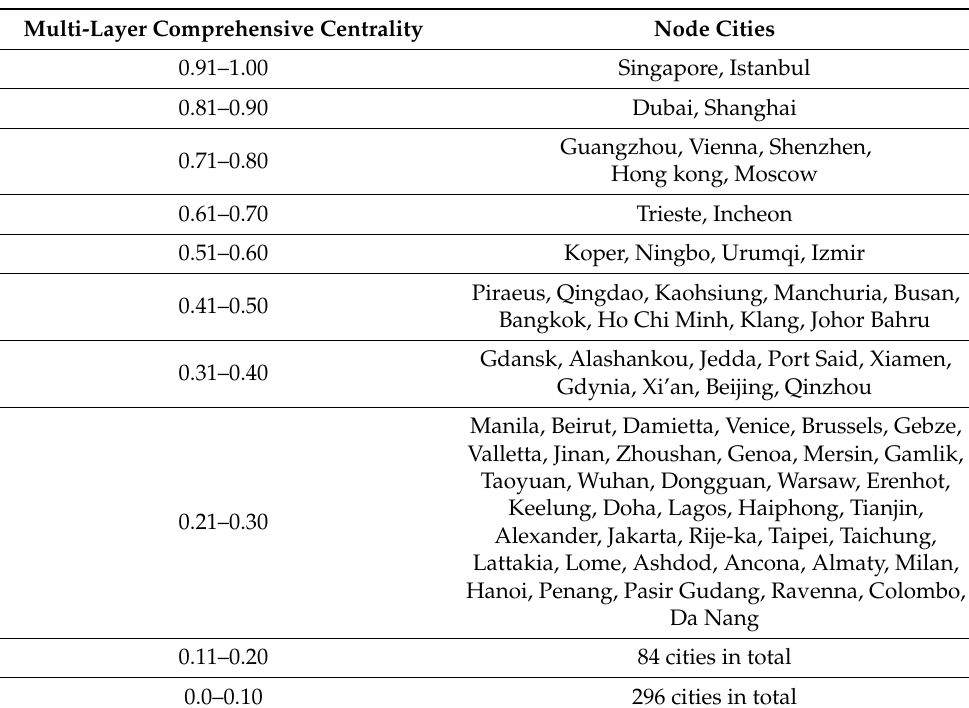
Table 3. Node cities in different regions of multi-layer comprehensive centrality. Multi-Layer Comprehensive Centrality